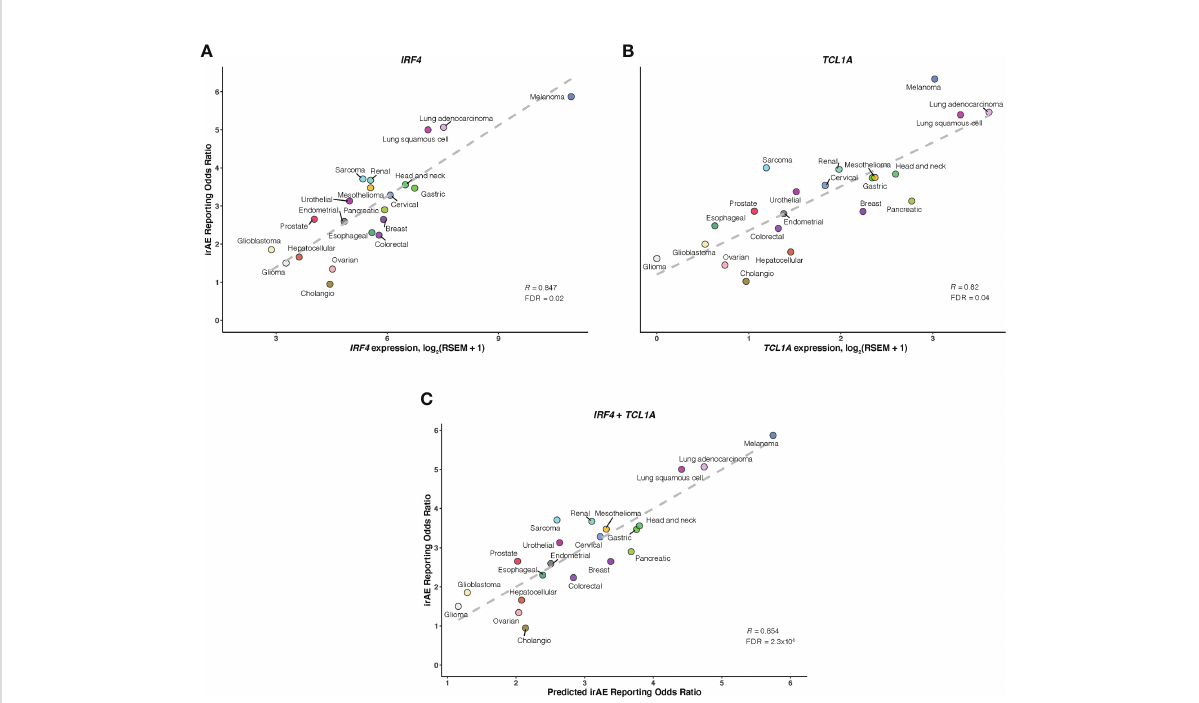
FIGURE 4 Association of IRF4 and TCL1A with Immune-Related Adverse Events for Anti – PD-1 Therapy Across Cancer Types A and B, Correlation of IRF4 (A) and TCL1A (B) mRNA expression with the reporting odds ratio (ROR) of any immune-related adverse event (irAE) across 21 cancer types which are color coded. The dashed line depicts the linear fi t. (C) , Combined effect of IRF4 and TCL1A expression bivariate model. The dashed line depicts linear fi t, with the formula ROR = 0.38 × IRF4 + 0.54 × TCL1A –